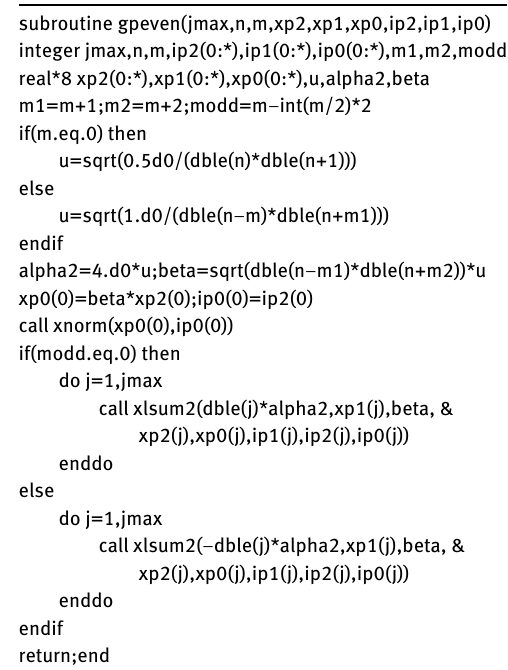
Table 6: Fortran subroutine to return P nmj when n is even. The re- turned values are ( xp0 ( j ), ip0 ( j )) , a double precision X-number vector representing P nmj . We assume that P n , m +1, j and P n , m +2, j are externally provided as ( xp1 ( j ), ip1 ( j )) and ( xp2 ( j ), ip2 ( j )) , respec- tively. The subroutine internally calls xnorm and xlsum2 provided in Tables 7 and 8 of Fukushima (2012a).